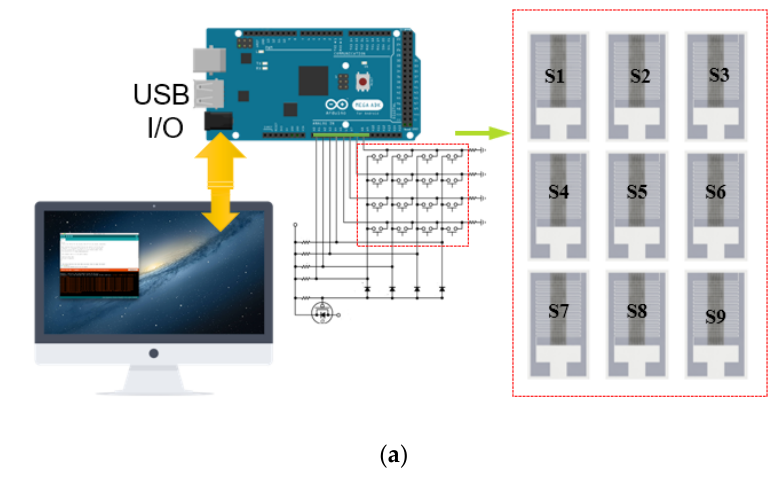
Figure 21. PVDF electrospinning voltage output value of tapping electrode at different frequencies in the stepper motor and the servo motor. Sensors 2020 , 20 , x FOR PEER REVIEW